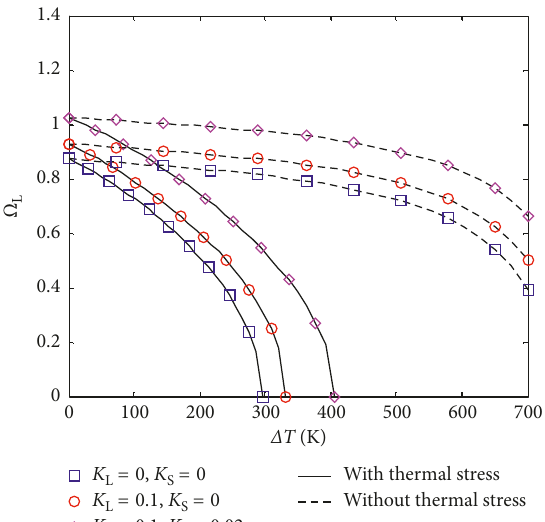
Figure 4: The effect of the temperature rise together with the initial thermal stress on the dimensionless linear fundamental frequency of FG-CNTRC beams with various elastic founda- tions ( H 0 . 1m, L / H 25, K NL 0, and V (cid:29) (cid:29) (cid:29)